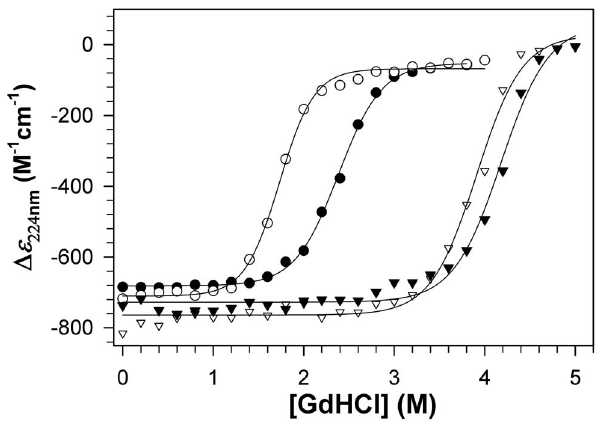
Figure 7. RP-mutant Ca MnSODc is more subject to GdHCl- induced unfolding than the wild type. The molar CD at 224 nm was used to monitor changes in a -helical structure content as a function of [GdHCl]. The enzymes were WT Sc MnSOD (solid triangle), K182R, A183P Sc MnSOD (hollow triangle), WT Ca MnSODc (solid circle) and K184R, L185P Ca MnSODc (hollow circle). The sample solutions contained 0.2 mg/mL (monomer concentration) MnSOD in 25 mM potassium phosphate (pH